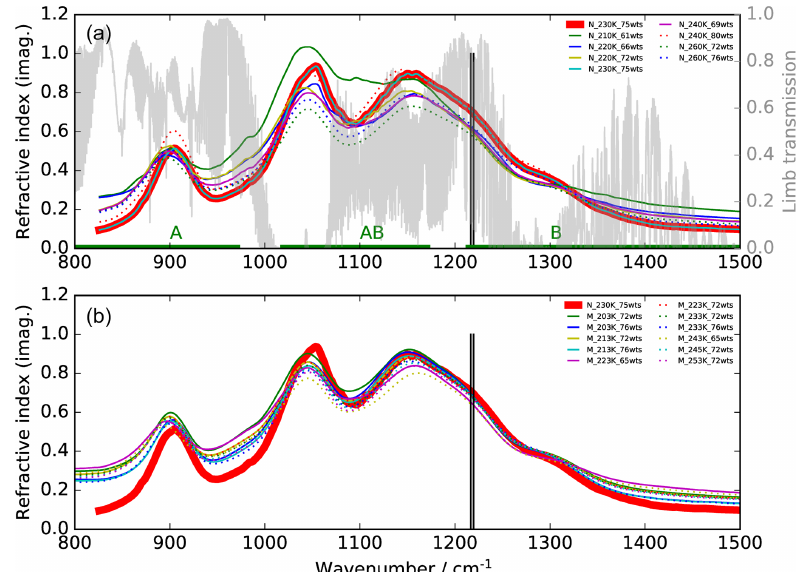
Figure 1. Imaginary parts of refractive indices for aqueous H 2 SO 4 solutions of different concentrations (wts: weight % H 2 SO 4 ) and different temperatures in the mid-infrared region. (a) Thin solid and dotted curves: Niedziela et al. (1999); (b) Lund Myhre et al. (2003). The bold red line indicates the data set, and the two vertical lines the spectral window used in this study. A simulated limb transmission spectrum for 10km tangent altitude for standard midlatitude conditions is additionally plotted in the top row as are the wavenumbers covered by MIPAS bands A, AB, and